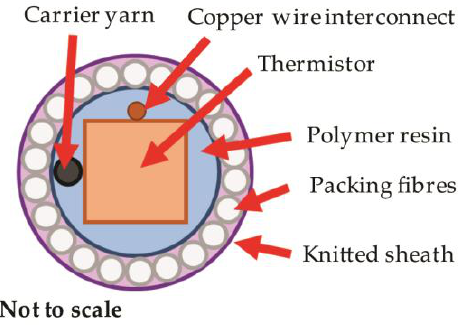
Figure 1. A cross-sectional schematic of the proposed encapsulation for a thermistor within a yarn. There are three layers—the polymer resin, packing fibres, and a knitted sheath. Each will retard the flow of heat to the thermistor, affecting the sensor’s response. The yarn would also include a carrier yarn within the resin encapsulation to improve the tensile strength of the final yarn.